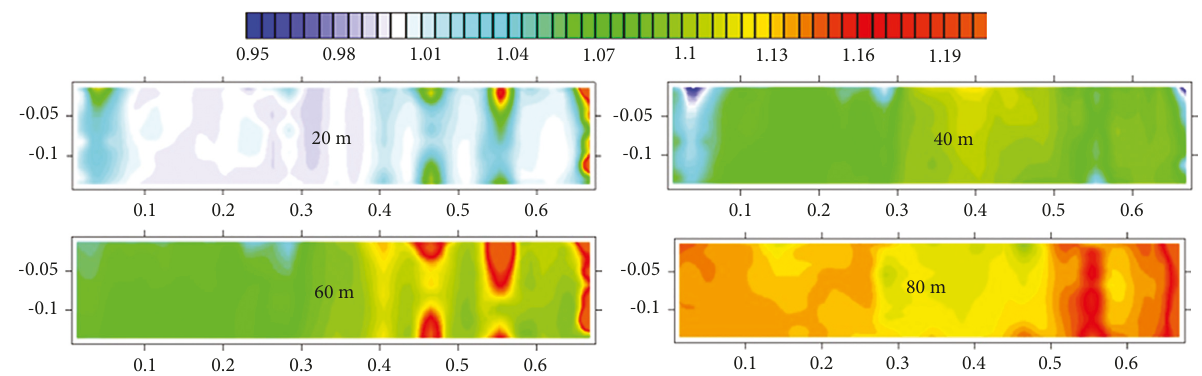
Figure 13: The resistivity section ratio chart in the x - z plane at 15cm above the coal seam ( y